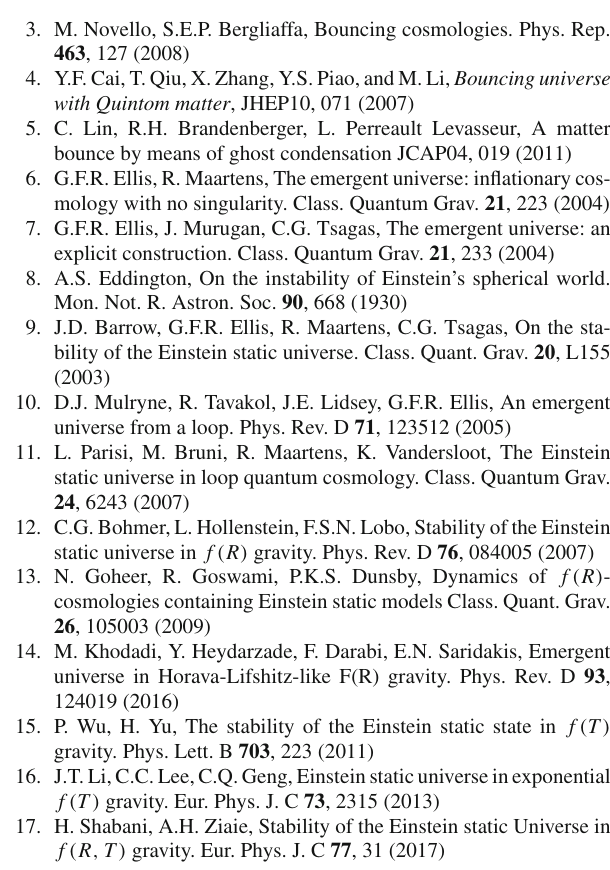
1 , S = 0 . 01 and k = − 1. By increasing q value, ρ and p increase rapidly for t → t s . The initial over-density and pressure in the lower plots are due to the smallness of a